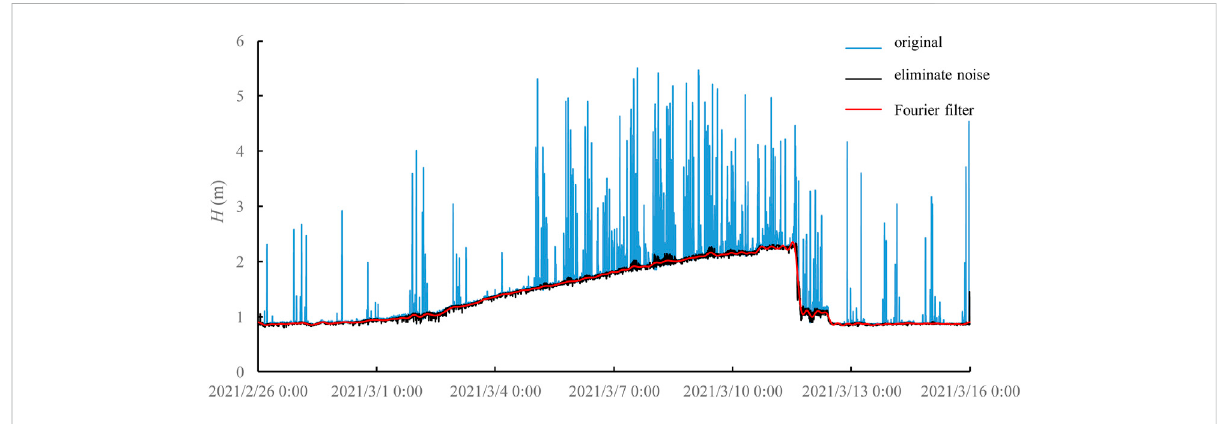
FIGURE 4 Data processing: the blue line is the original measurement data; the black line is the data after removing measurement noise; the red line is the general trend after removing small-scale fl uctuations through Fourier fi